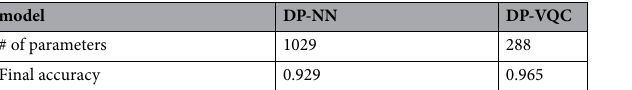
5 ) -differentially private neural network